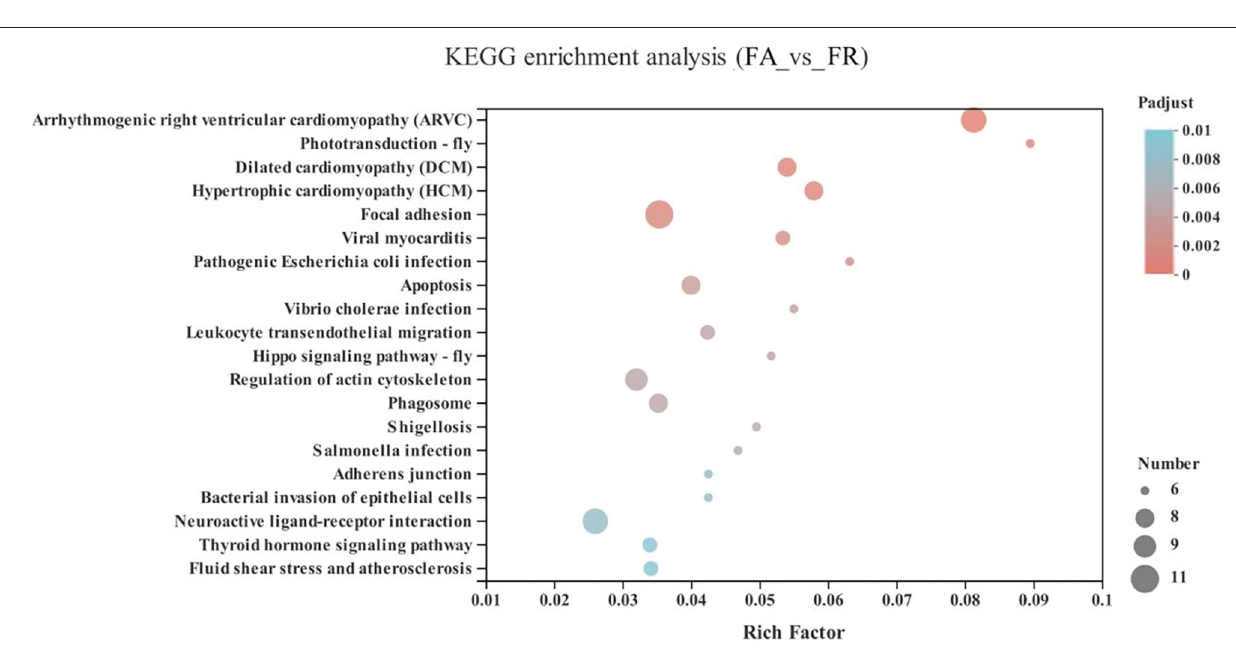
and energy were enriched between groups ( P <